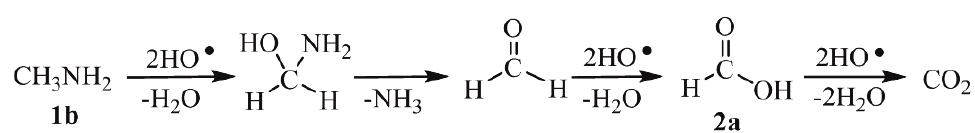
Figure 4. Decomposition of methylamine ( 1b ) and formic acid ( 2a ) by HO •